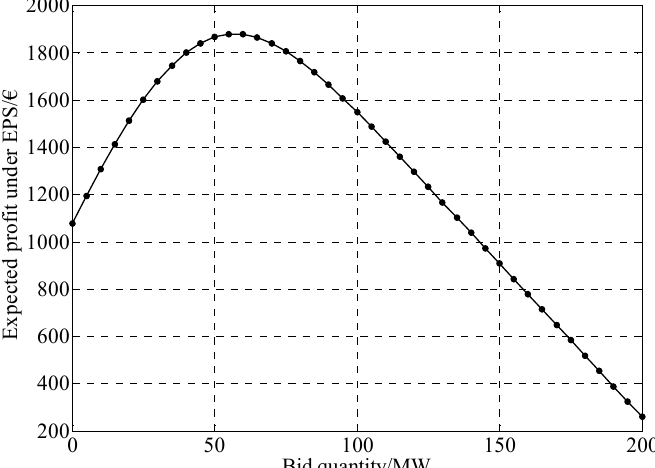
Figure 3. Expected profit under the EPS versus bid